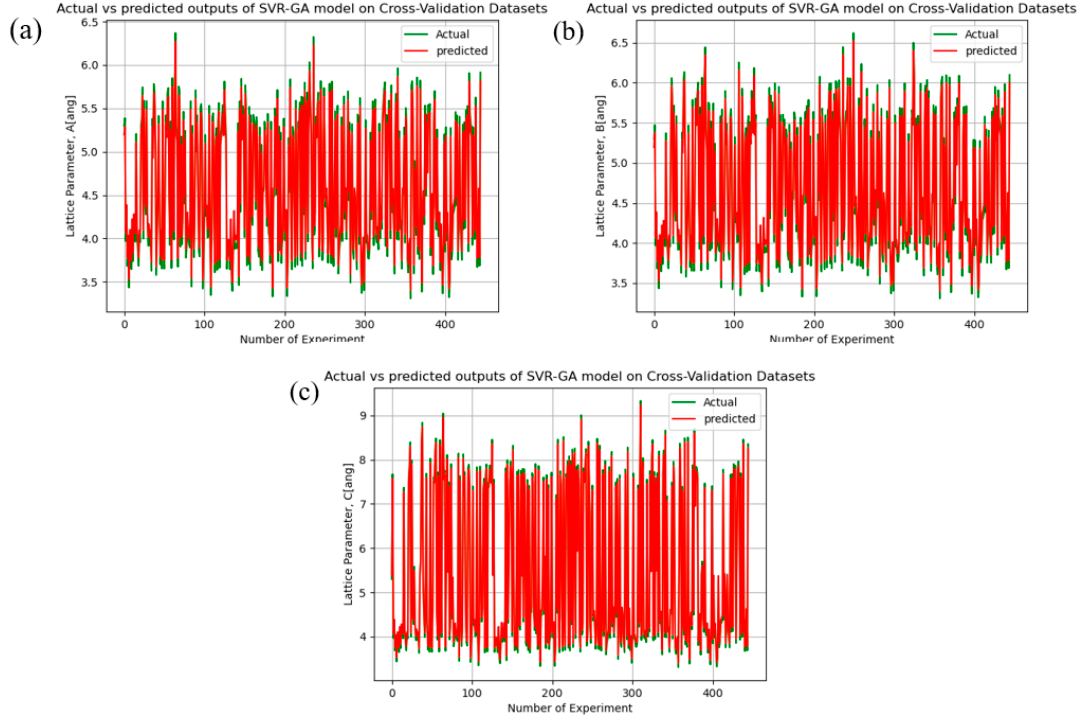
Figure 13. ( a – c ) The actual vs. predicted outputs ( a ) for a lattice parameter, ( b ) for b lattice parameter, and ( c ) for c lattice parameter of the cross-validation datasets by SVR-GA model.